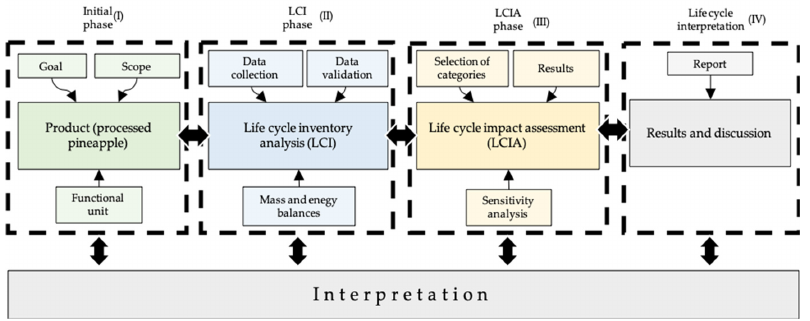
Figure 1. The methodology of life cycle assessment (LCA). Source: own elaboration based on [12,22].